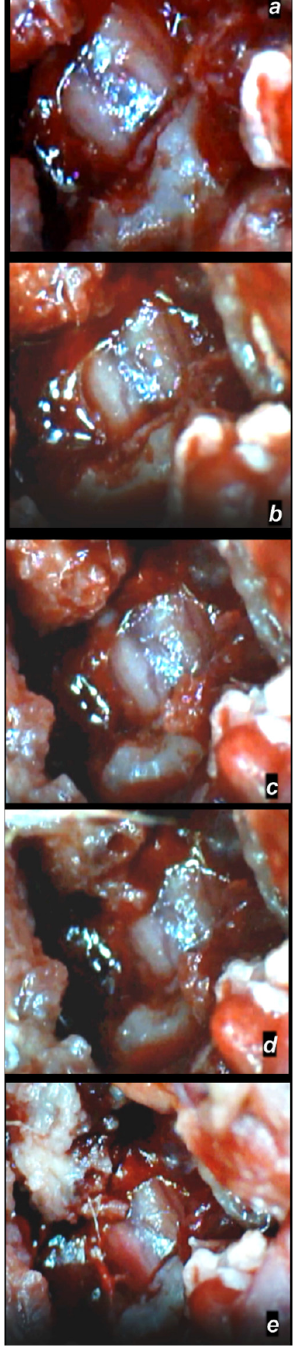
Figure 8. Spinal cord hematoma presentation following spinal cord compression (for 1 min), presen- tation at day 4 following injury (a camera attached to a VMS-004 Discovery Deluxe USB microscope (Veho, Denver, CO, USA)). Presentation before therapy ( a ), and, ( b – e ) after therapy with BPC 157 (10 μ g/kg ig) application, immediately ( b ), at 5 min ( c ), at 10 min ( d ), and at 20 min ( e ).